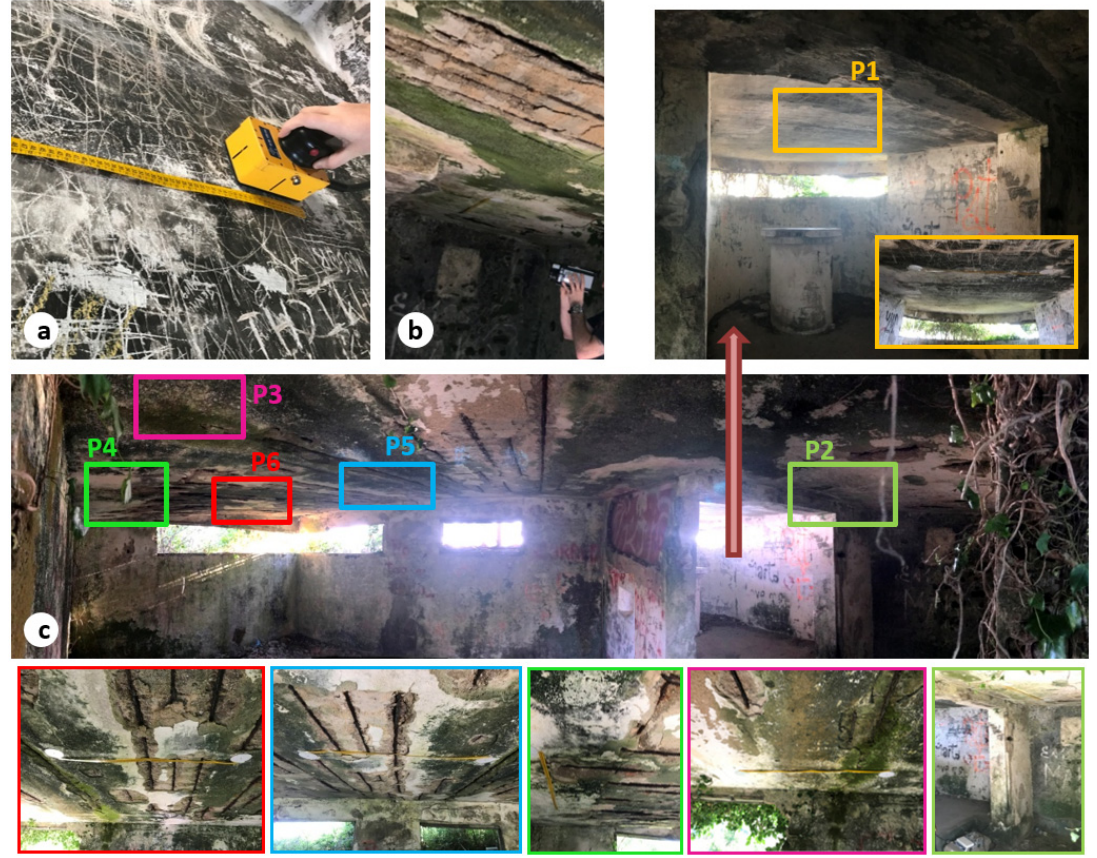
Figure 2. Instruments used for the study: ( a ) 2.3 GHz ground penetrating radar (GPR) antenna, ( b ) infrared thermography (IRT) camera and ( c ) location of the GPR profiles (P1 to P6) through the prospected area (panoramic view of the roof surface).